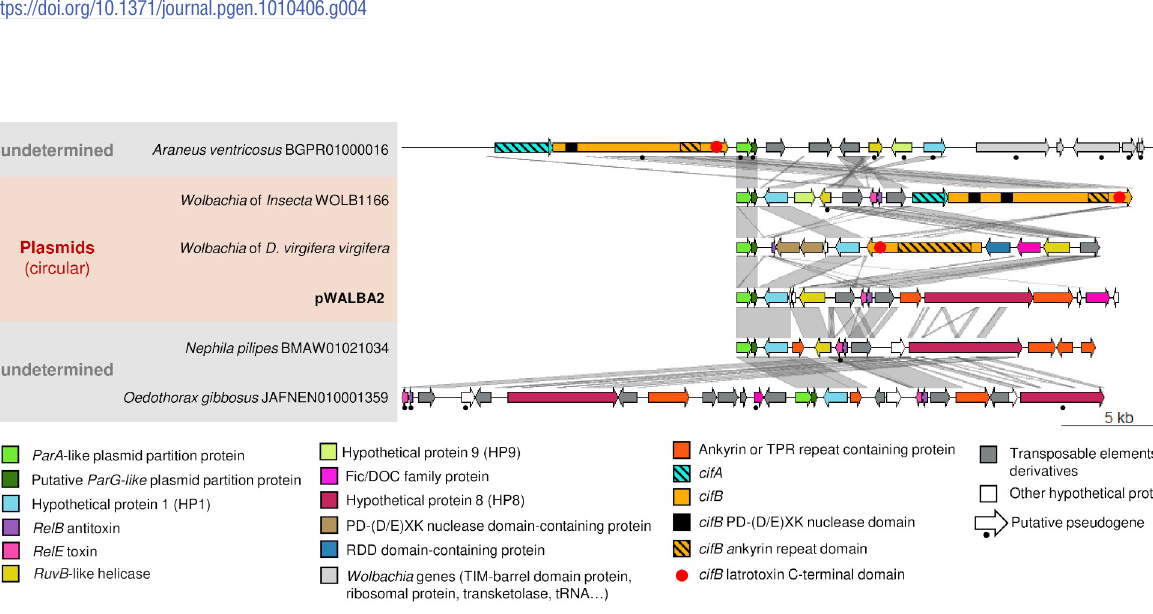
PLOS Genetics | https://doi.org/10.1371/journal.pgen.1010406 September 19, 2022 7 /